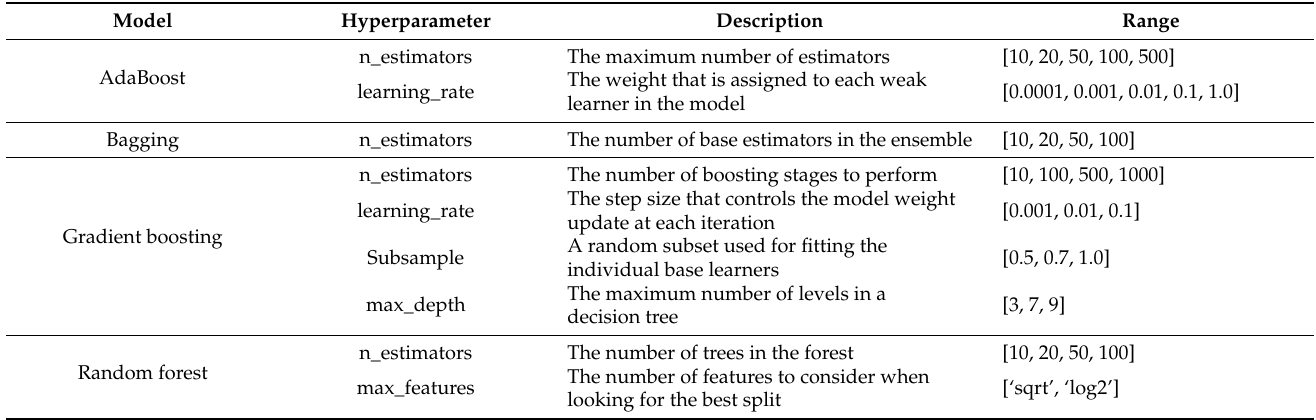
Table 6. Grid search hyperparameters and their range for all models.